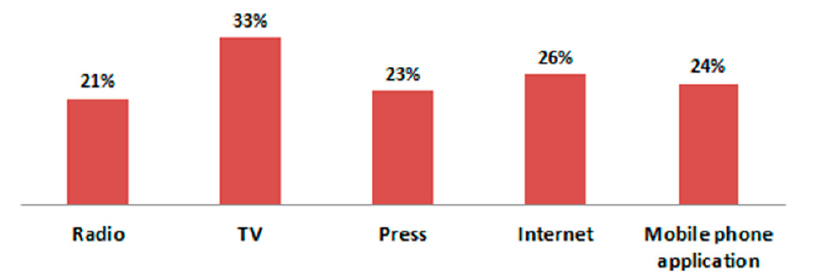
Figure 7. Sources of information used by patients regarding the level of air pollutants in their areas.